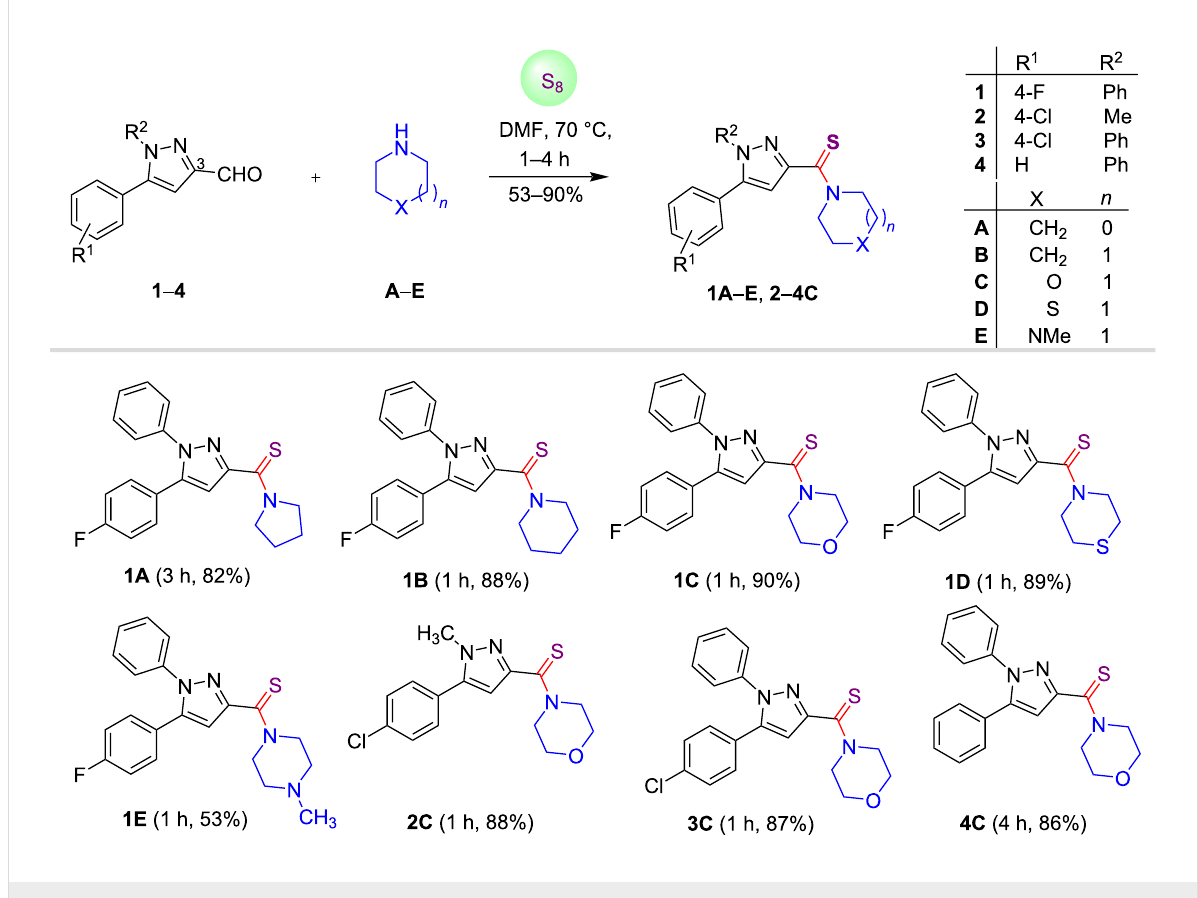
Scheme 1: Synthesis of pyrazole C-3-tethered